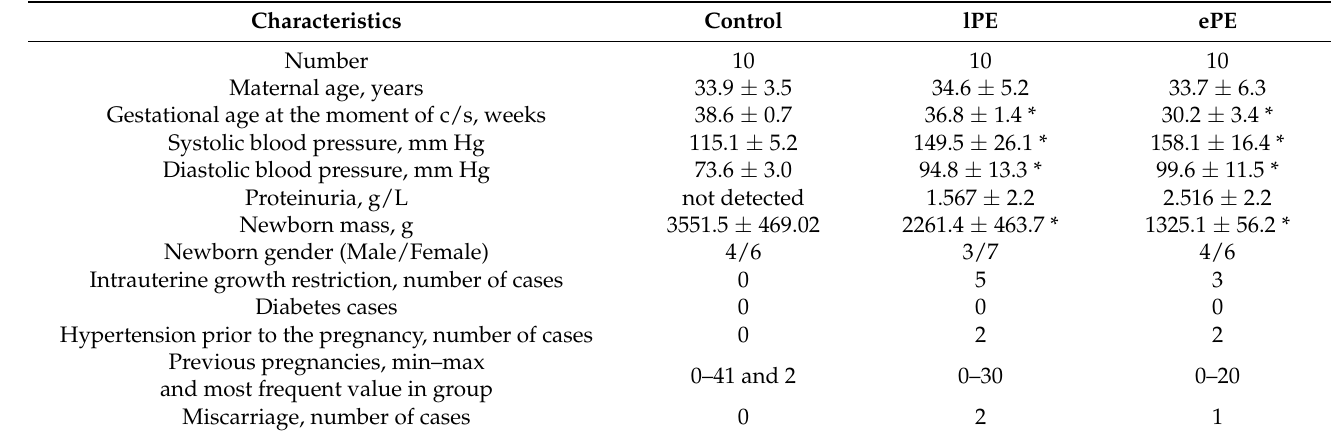
Table 1. Clinical characteristics of the